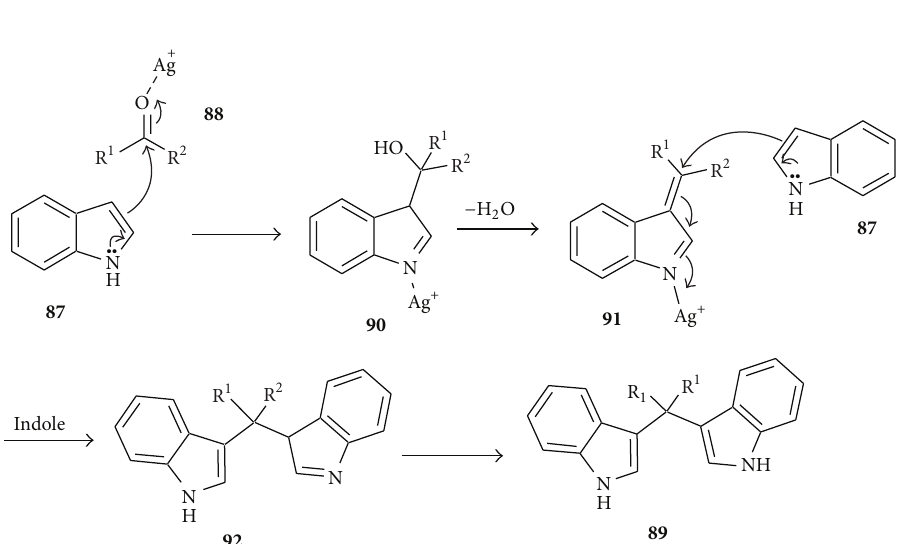
Scheme 18: AgBF 4 -mediated synthesis of C-7 indole-substituted aminonitriles.